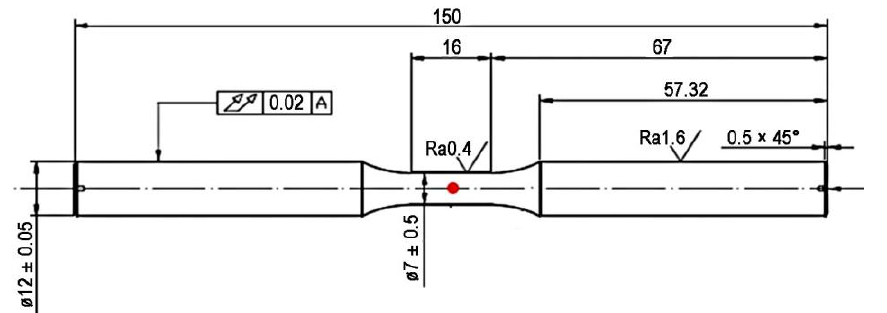
Figure 2. Dimensions (in mm) and shape of the TMF specimen (red dot indicates the position of the thermocouple).